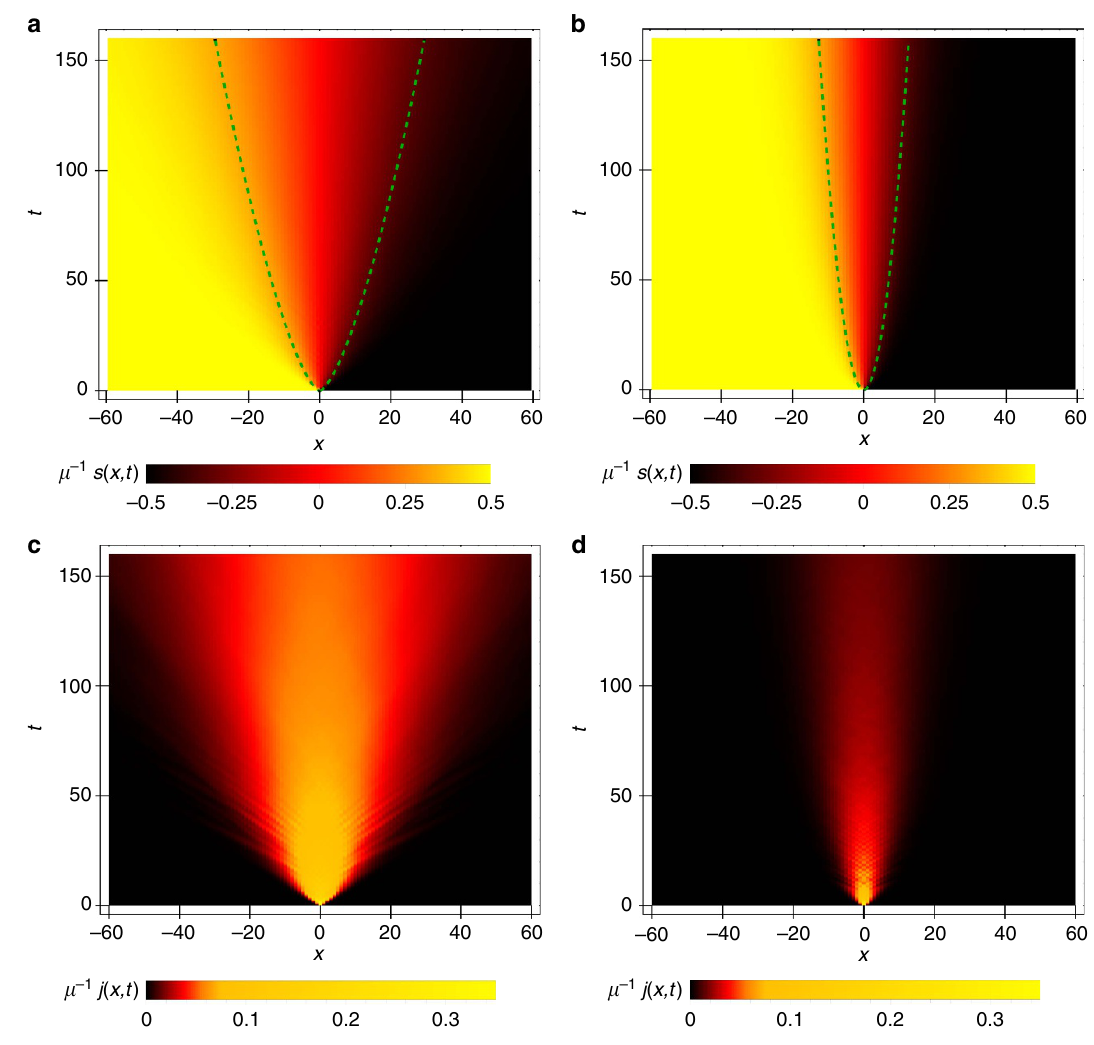
Figure 1 | Dynamics of spin and current densities. Time evolution of spin density s ð x ; t Þ¼ tr ð r ð t Þ s ð 3 Þ x Þ ( a , b ) and current ( c , d ) profile j ( x , t ) ¼ tr( r ( t ) j x ) for the isotropic point D ¼ 1 ( a , c ), and D ¼ 2 ( b , d ), following an inhomogeneous quench. One can see that the spreading is much faster for D ¼ 1, in both cases though it is slower than ballistic. Dashed green curves guide the eye towards scaling x B t 2/3 in a , and x B t 1/2 in ( b ). Data are shown for n ¼ 320 and small initial polarization m ¼ p